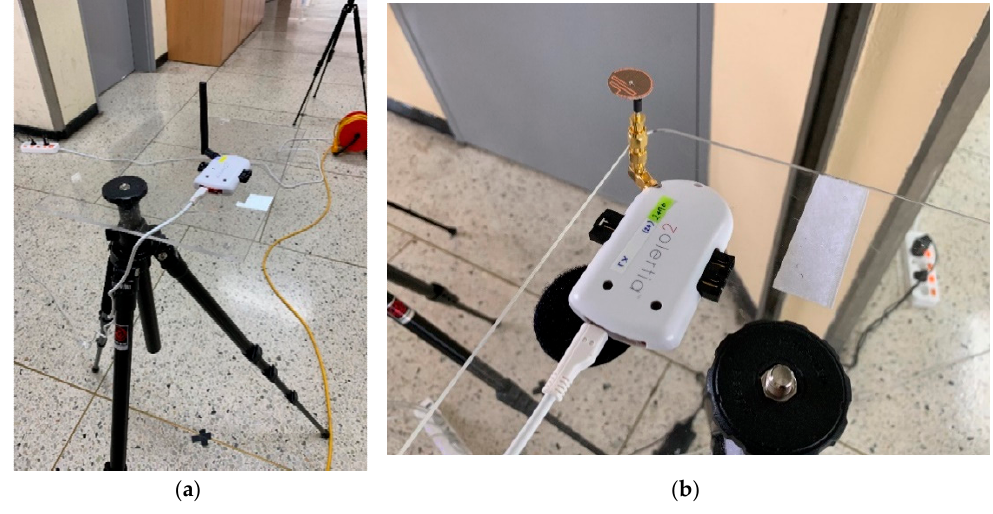
Figure 11. Antennas for the performance evaluation setup: ( a ) Zolertia board with default omni-directional antenna and ( b ) Zolertia board with quasi-isotropic antenna.